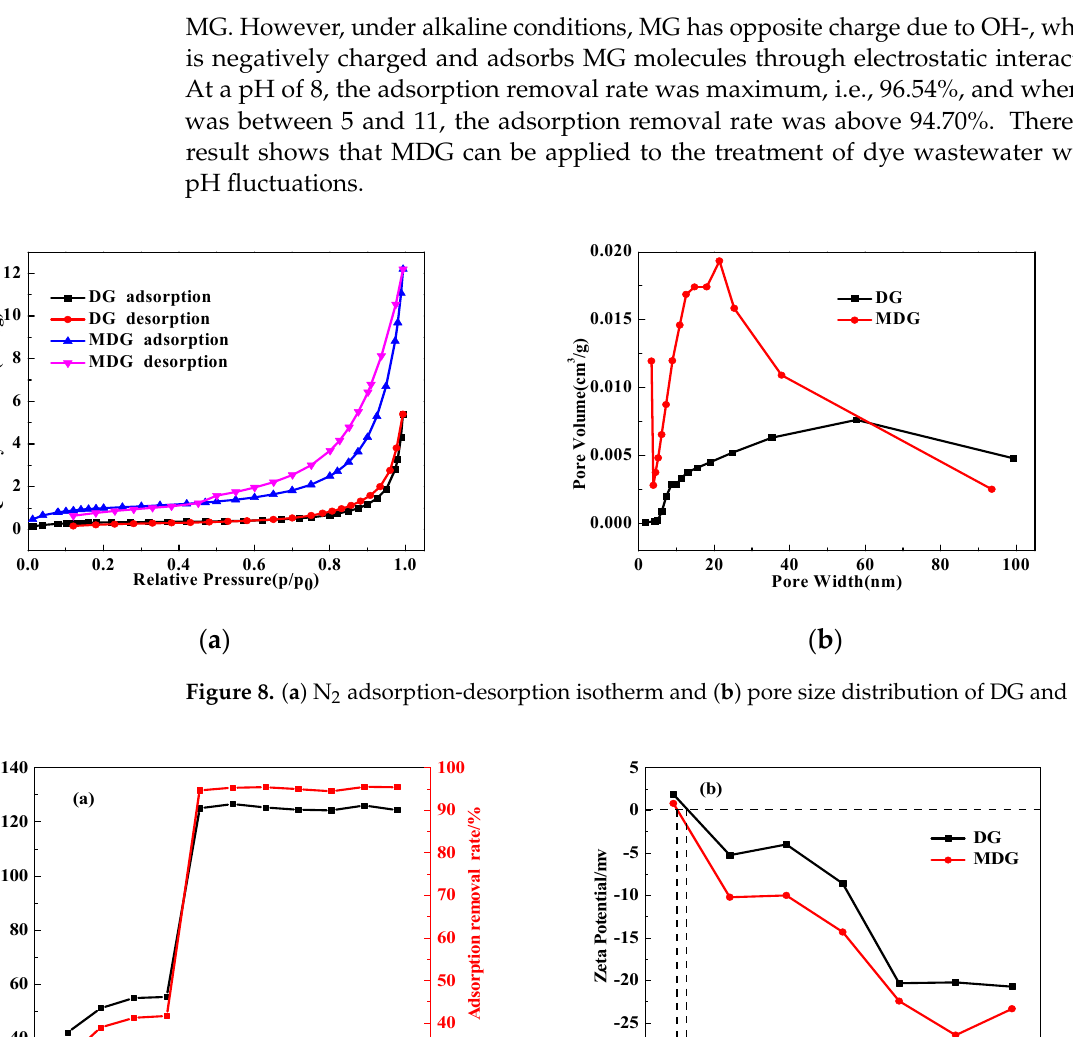
Figure 10. The photograph of ( a ) MG solution, ( b ) DG, and ( c ) MDG adsorption of MG solution. Table 2. The adsorption performance parameters of DG and MDG on MG solution. Sample